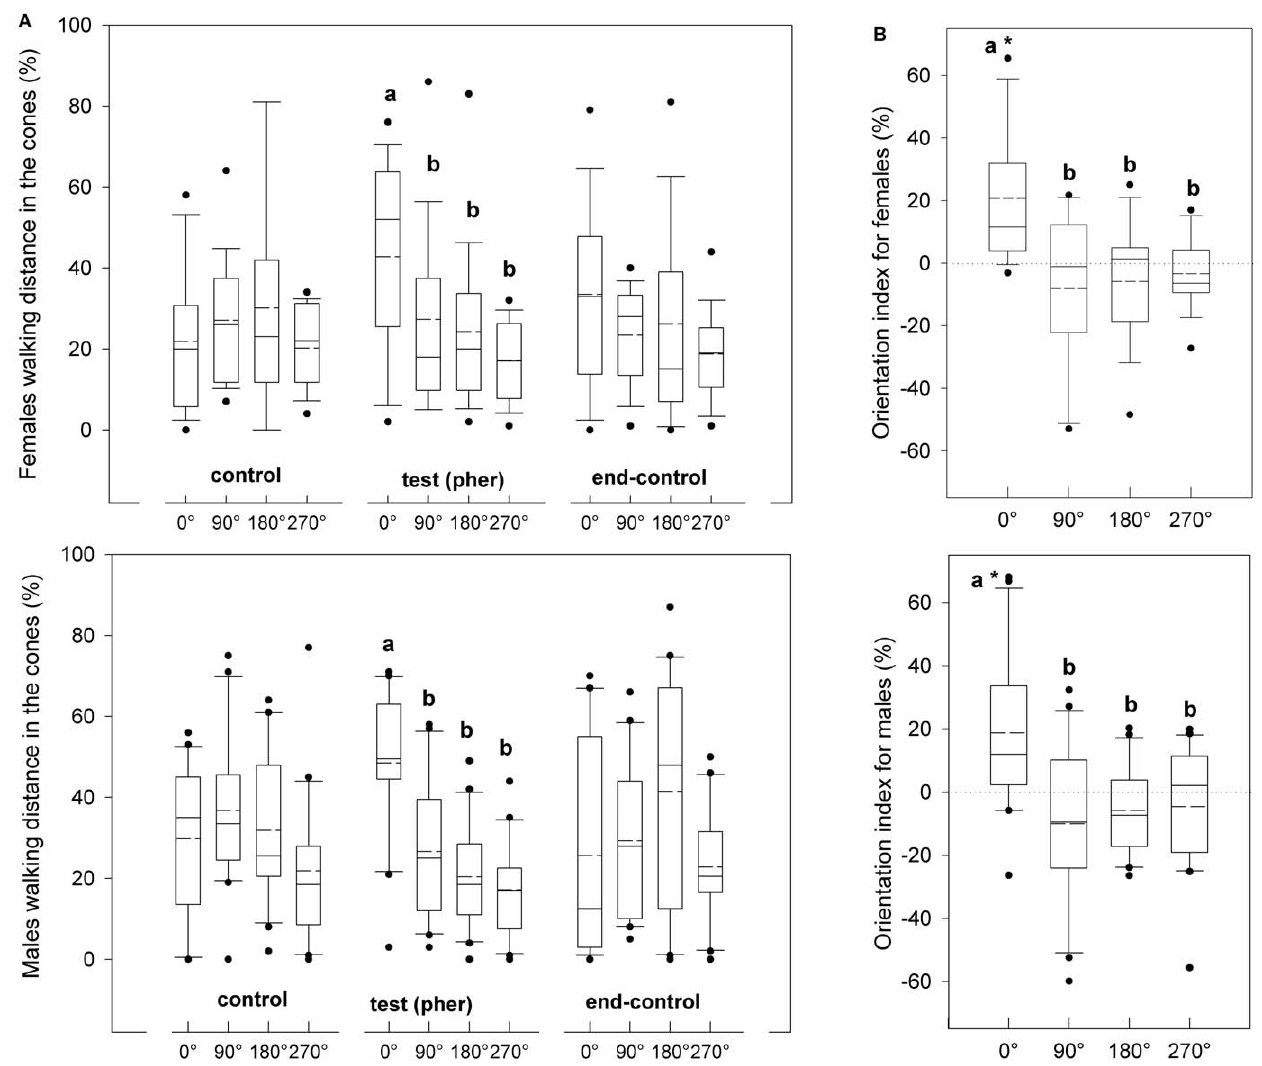
Figure 2. Orientation of Colorado potato beetle to aggregation pheromone in darkness. Orientation behaviors of female and male CPBs stimulated with a male-produced aggregation pheromone ( S )-CPB I in an air stream (pher) a. Proportion of distance covered during the three experimental periods (control, test and end-control) in each of four 120 u cones projected to 0 u , 90 u , 180 u and 270 u respectively. b. Orientation index calculated as the proportion of distance covered in each cone during the test period minus the proportion of the distance covered in each cone during the first control period. Asterisks (*) indicate means that are significantly different from zero (Wilcoxon signed rank test, p , 0.05). Different letters indicate significant pairwise differences across the different directions (Dunn’s post-hoc test, p , 0.05). In the boxplots, the line within a box mark the median, the segmented line within a box mark the mean, the lower and upper boundary lines of a box indicate the 25 th and 75 th percentiles, bars below and above indicate the 10 th and 90 th percentiles, respectively, and the points represent data beyond these